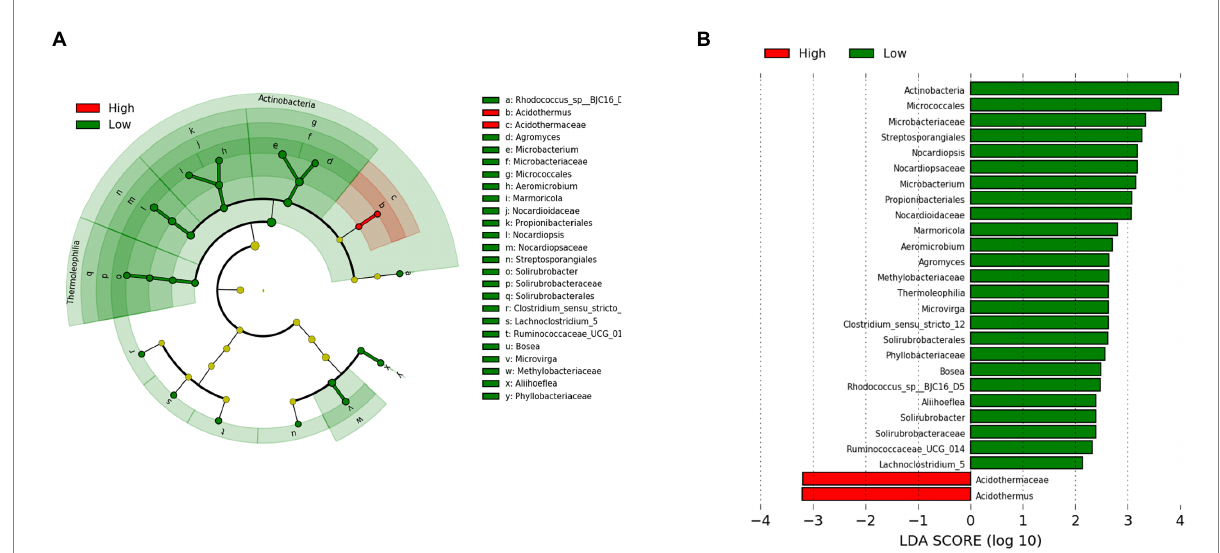
FIGURE 5 The taxa whose abundance differed between high latitudinal individuals (Wenzhou and Ningbo) and low latitudinal individuals (Yangjiang and Shantou) were identified by LDA effect size (LEfSe). (A) Taxonomic cladogram obtained from LEfSe analysis of sequences (relative abundance ≥ 0.5%). Biomarker taxa are highlighted by colored circles and shaded areas (high latitudinal samples are shown in red and low latitudinal samples are shown in green). Each circle’s diameter reflects the abundance of that taxa in the community. (B) The taxa whose abundance differed between